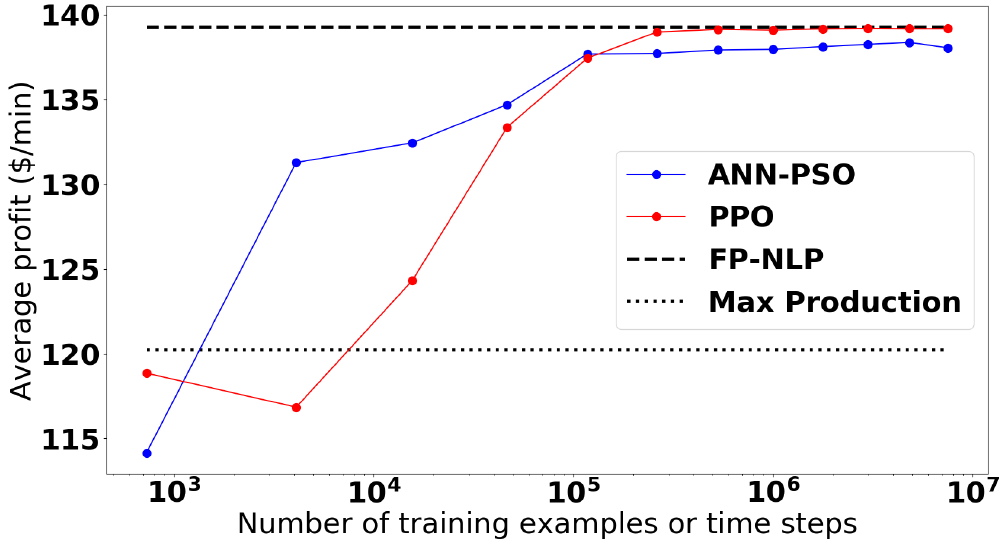
Figure 4. Methods’ learning curves on continuously stirred tank reactor (CSTR)